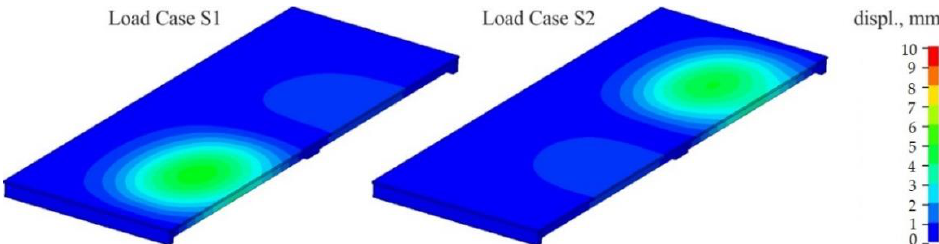
Figure 8. Resultant displacements for load cases S1 and S2 .